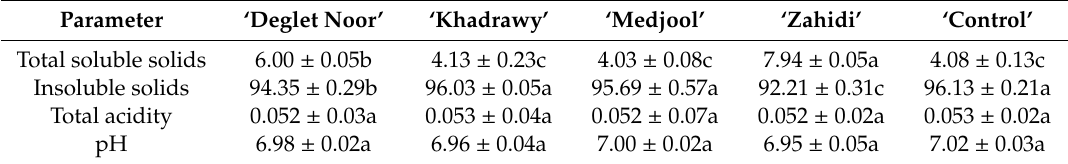
Table 3. Content of total soluble solids, insoluble solids, total acidity, and pH of ‘Medjool’ date seeds obtained from fruit resulting from pollination using pollen from ‘Deglet Noor’, ‘Khadrawy’, ‘Medjool’, and ‘Zahidi’ cultivars. Control is a pollen mixture from random date palm male plants used by the grower. All parameters are expressed in g / 100 g dry